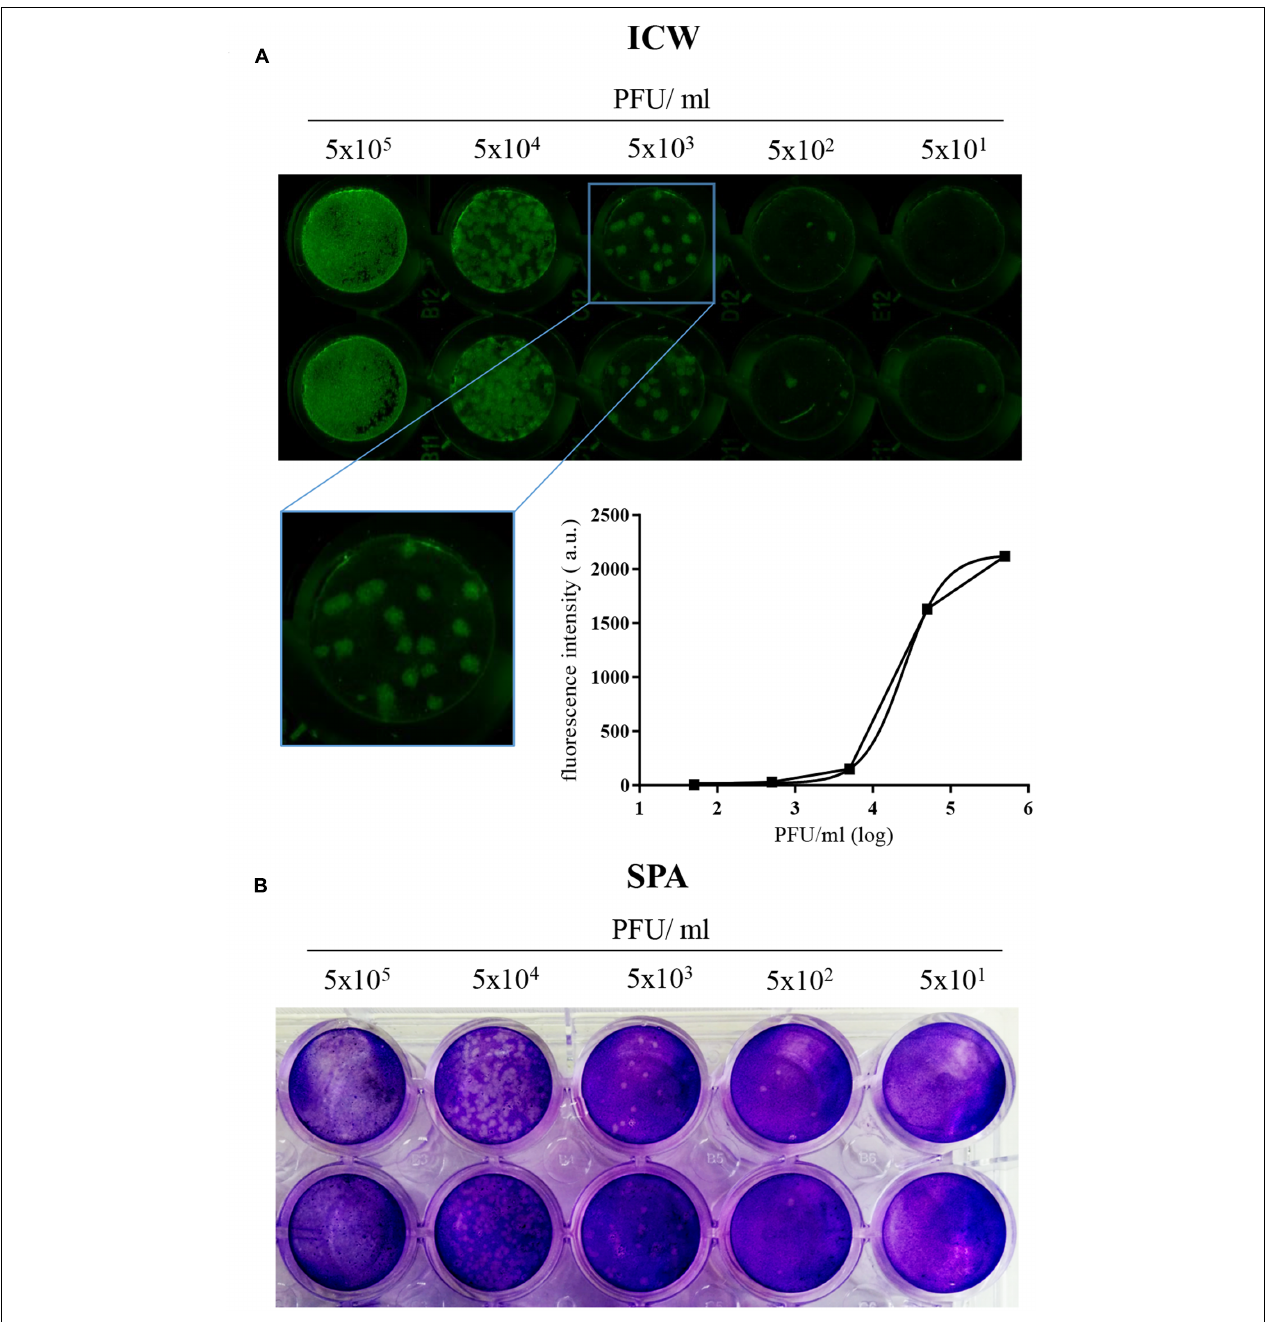
FIGURE 1 | “In-Cell Western TM ” Assay is a suitable technique to detect HSV-1 infection in cells. (A) Vero cells were seeded in 96 wells and infected with the indicated 10-fold serial dilutions of HSV-1. 24 h p.i. cells were fixed and immunostained with anti-gB antibody, followed by incubation with IRDye 800CW goat anti-mouse antibody, and relative fluorescence detected with LI-COR Odyssey Infrared Imaging System. A representative image of one of the three experiments performed is shown, with a close up image of HSV-1 foci of infection (inset) and the relative standard curve built up with the mean value of fluorescence intensity (arbitrary unit, a.u.) detected for each experimental point. (B) Representative image of SPA performed with the same HSV-1 dilutions used in (A) .